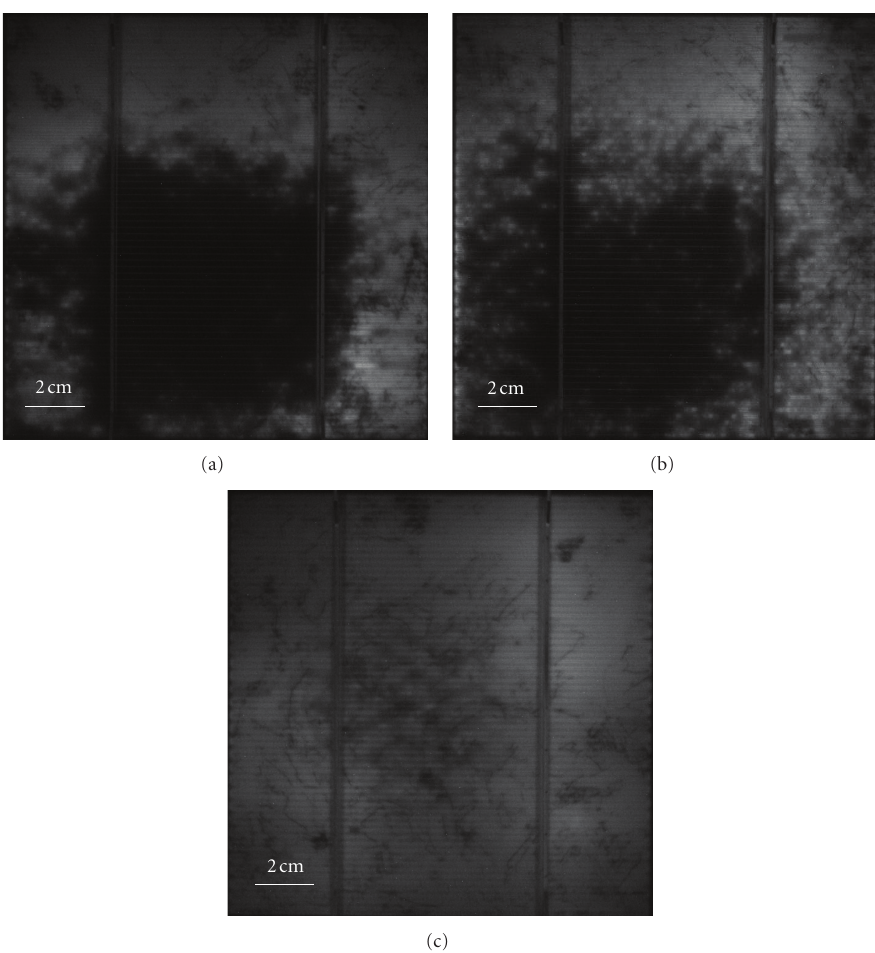
Figure 5: 6 (cid:2)(cid:2) mc-Si PV solar cells with surface texture using 1 μ m, 600 nm, and 100 nm-thick nanorods shown from (a) to (c) are tested by electroluminescence (EL) to investigate the doping uniformity in cells. The lateral nonuniform doping introduces defects (the dark regions) in solar cells, largely suppressing the minority carrier lifetime and the IR light irradiation. The solar cell decorated with 100 nm- thick nanorods has few dark areas, showing the better doping